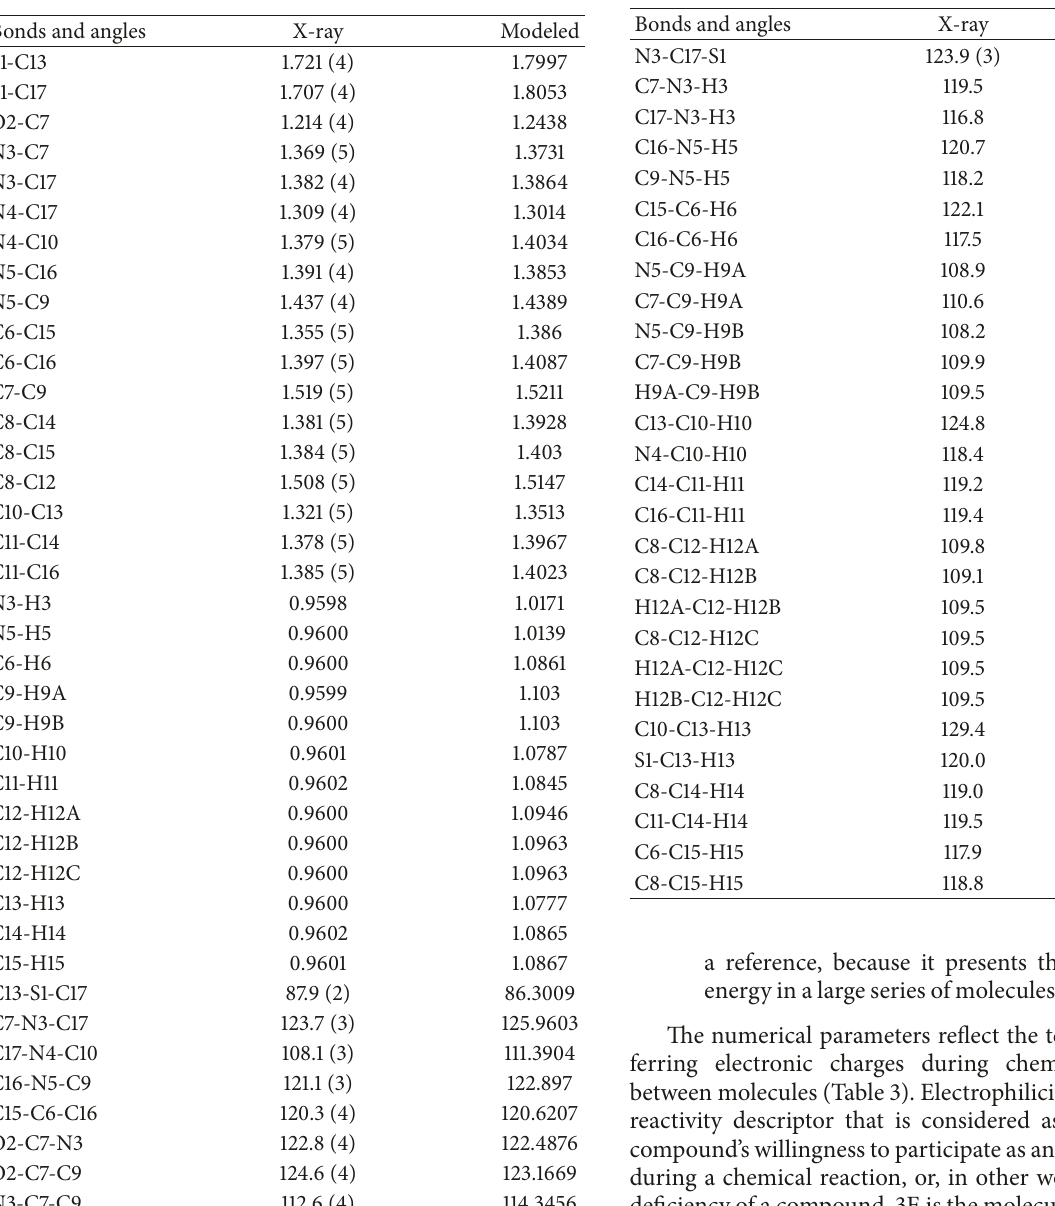
Table 2: Geometric parameters (˚A, ∘ ). Table 2: